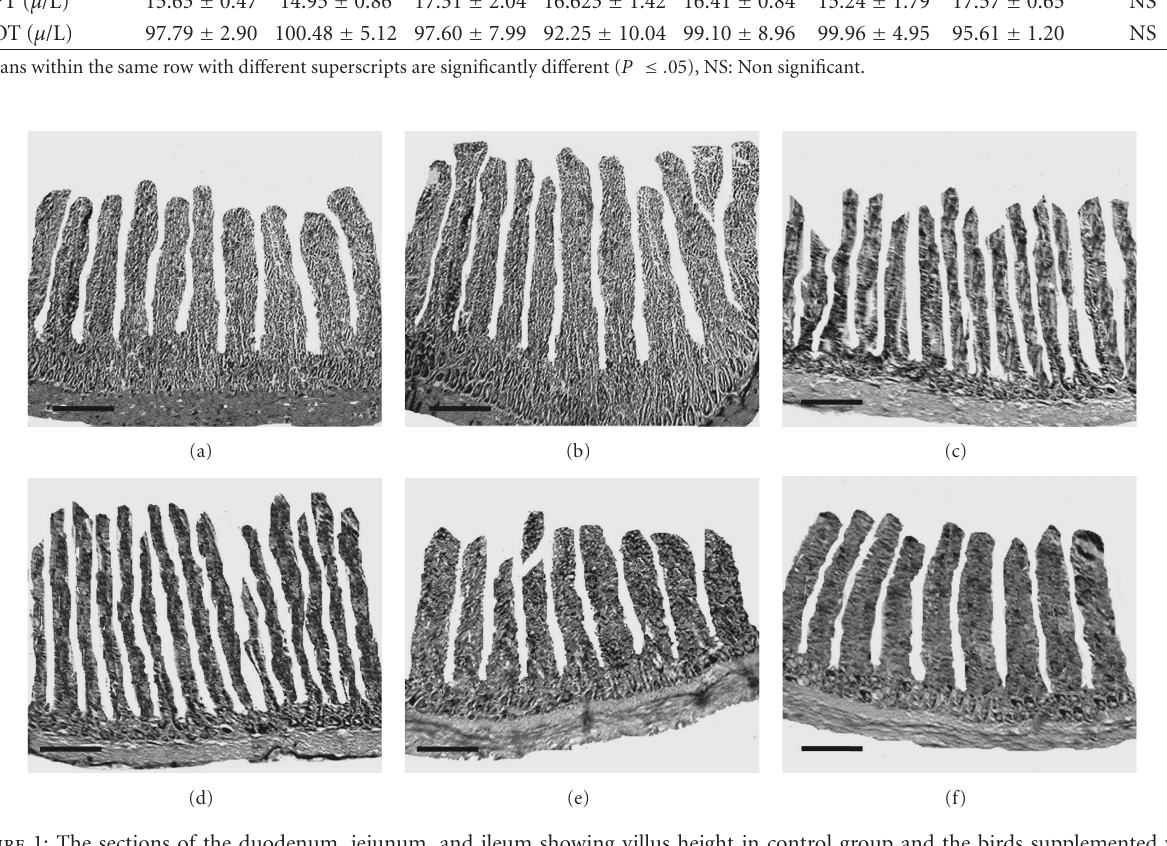
fumaric acid, and 2% fumaric acid, respectively (Figure